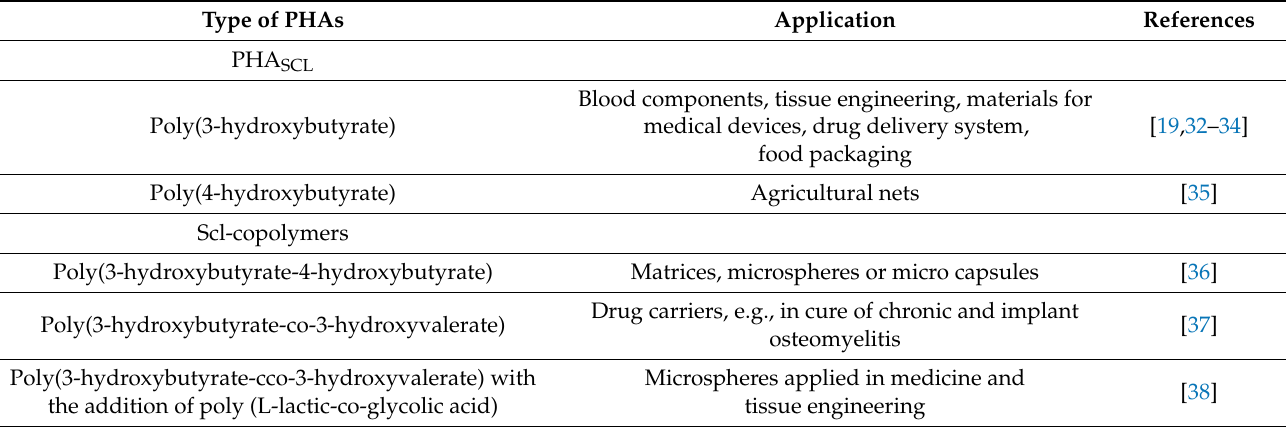
Table 2. Possible applications of various types of